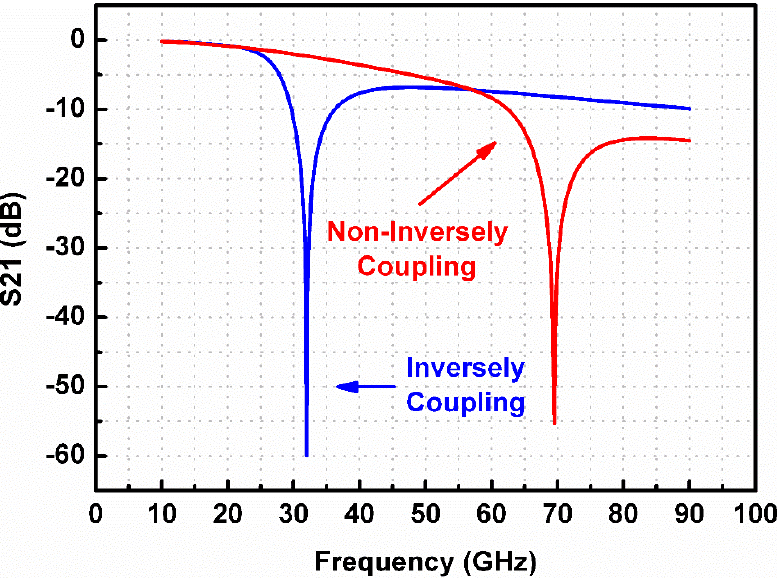
Figure 3. Simulated transmission zeros with inversely and non-inversely coupled transmission lines based resonators.